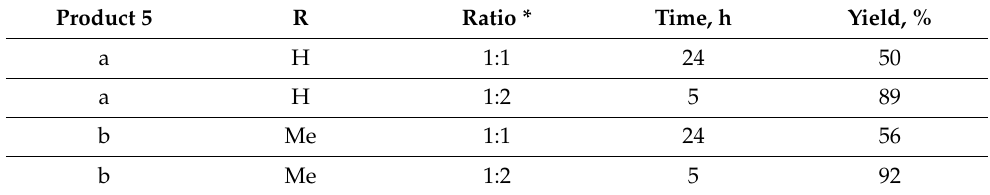
Table 1. The ratio of the reagents, reaction time and yields of 5a and 5b , Scheme 1 ( iii ). Product